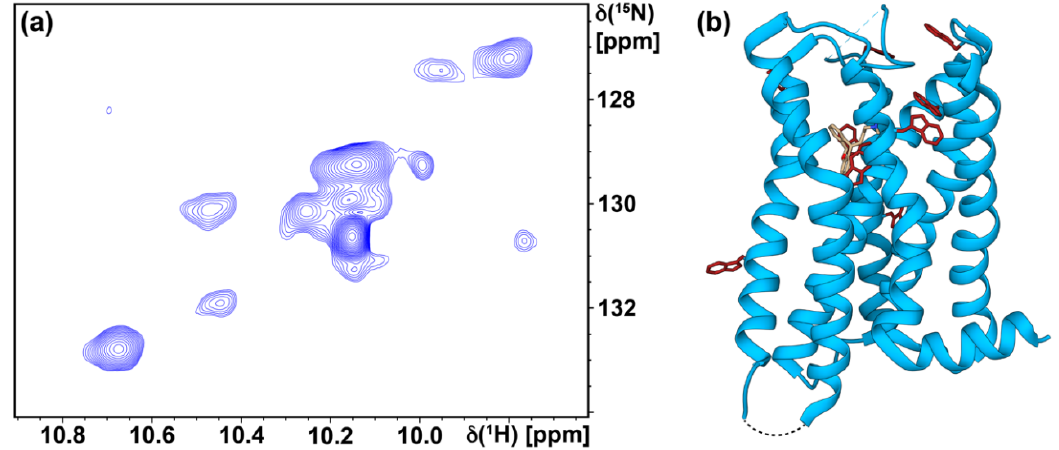
Figure 6. ( a ) An expanded view is shown of the tryptophan indole 15 N– 1 H region of the TROSY correlation spectrum, corresponding to the dashed box in Figure 5a. ( b ) The crystal structure of the H 1 R complex with doxepin is shown in ribbon representation (PDB ID 3RZE [9] ), and the 9 tryptophans in H 1 R are shown in red in stick representation. The blue dashed line represents missing electron density in the crystal structure for amino acids 168 to 174, and the black dotted line represents the location of T4L in the crystal structure. The bound doxepin ligand is shown in brown in stick representation.